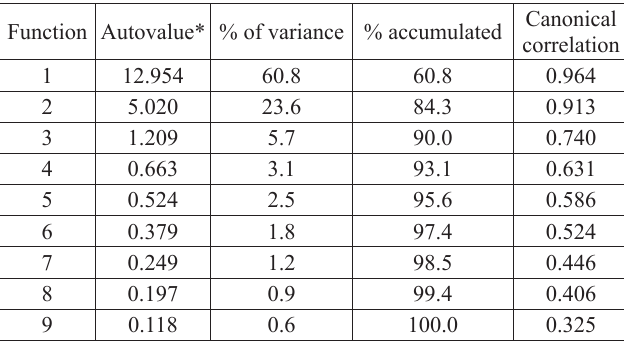
Table 2. Autovalues and percentage of variance explained by the nine canonical vectors used in the DFA. The canonical functions used in the XY graph account 84.3% of the variance. * the 9 first discriminant canonical functions are used in the